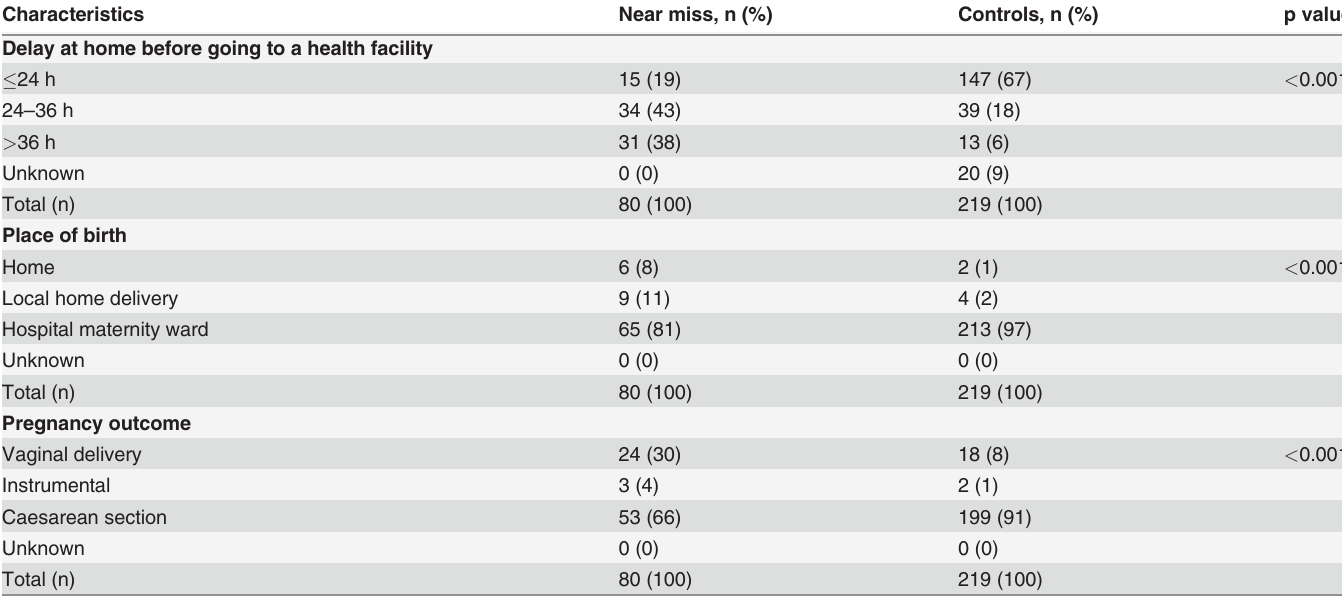
Table 3. Monitoring of